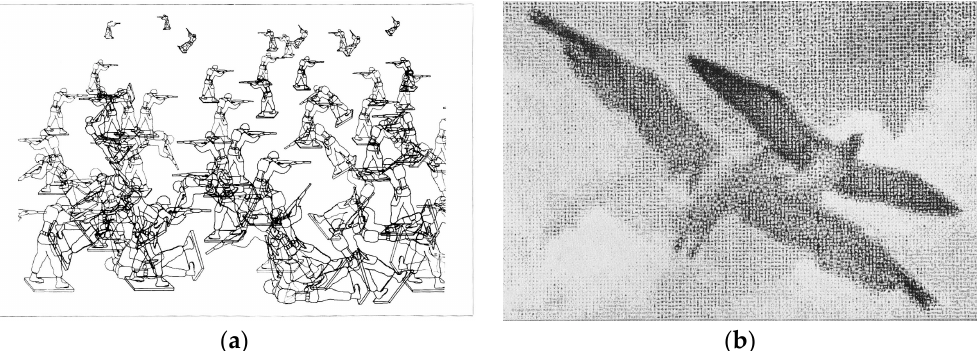
Figure 7. Some artistic elaborations with computer: ( a ) C. Csuri, J. Shaffer, Random war ; ( b ) K.C. Knowlton, L.D. Harmon, Gulls: studies in perception II